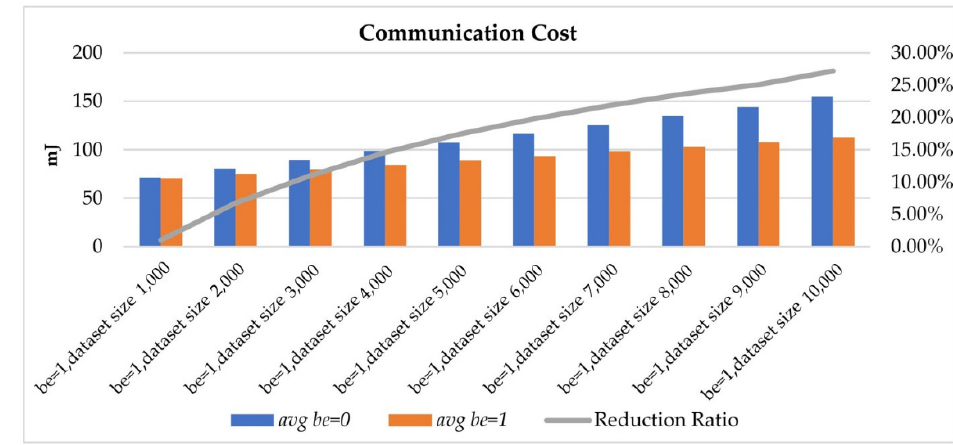
Figure 14. The power consumption of querying different-size datasets.